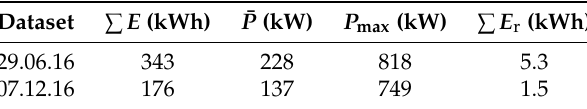
Table 7. Vessel run data